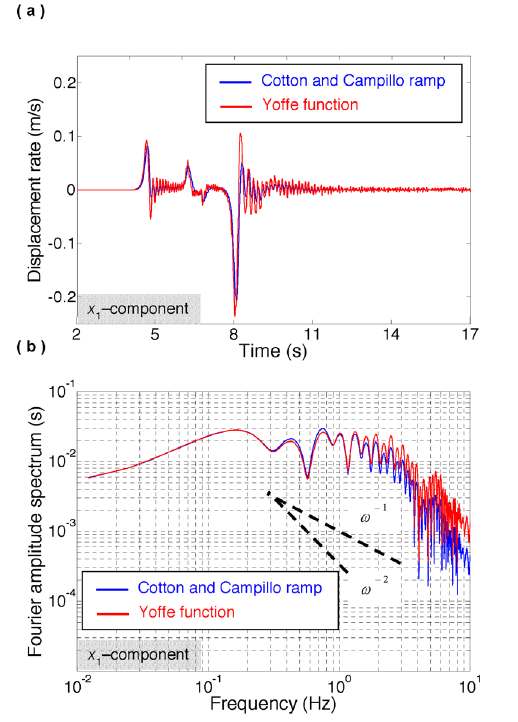
Figure 7. (a) The same as Figure 3a, but now for a free surface re- ceiver located at a distance of 25 km from the epicenter and 10 km from the fault trace. (b) Corresponding FAS.